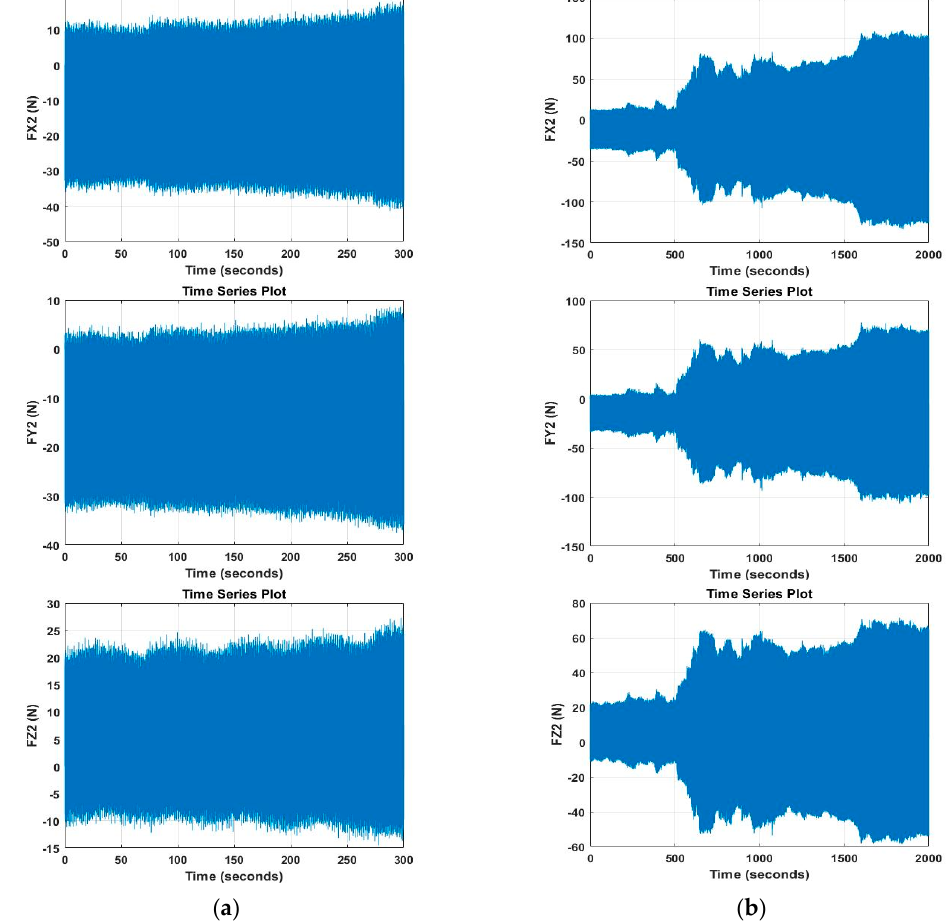
Figure 12. Force transmission results for aiming unit from GUI: ( a ) results for case I; ( b ) results for case II.